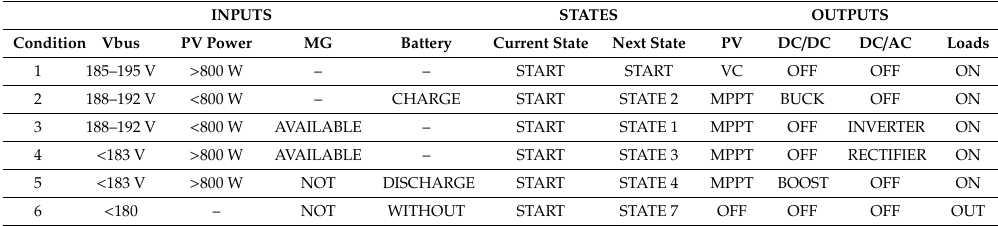
Figure 7. Global management controller (GMC) state machine diagram. Table 3. GMC START